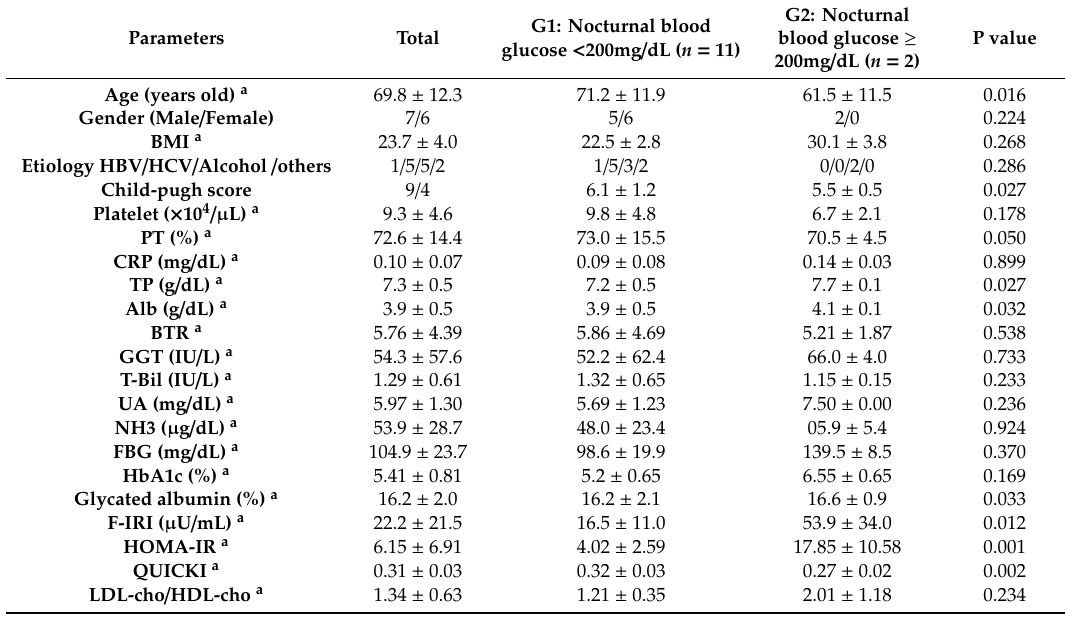
Table 1. Clinical and demographic characteristics of patients with